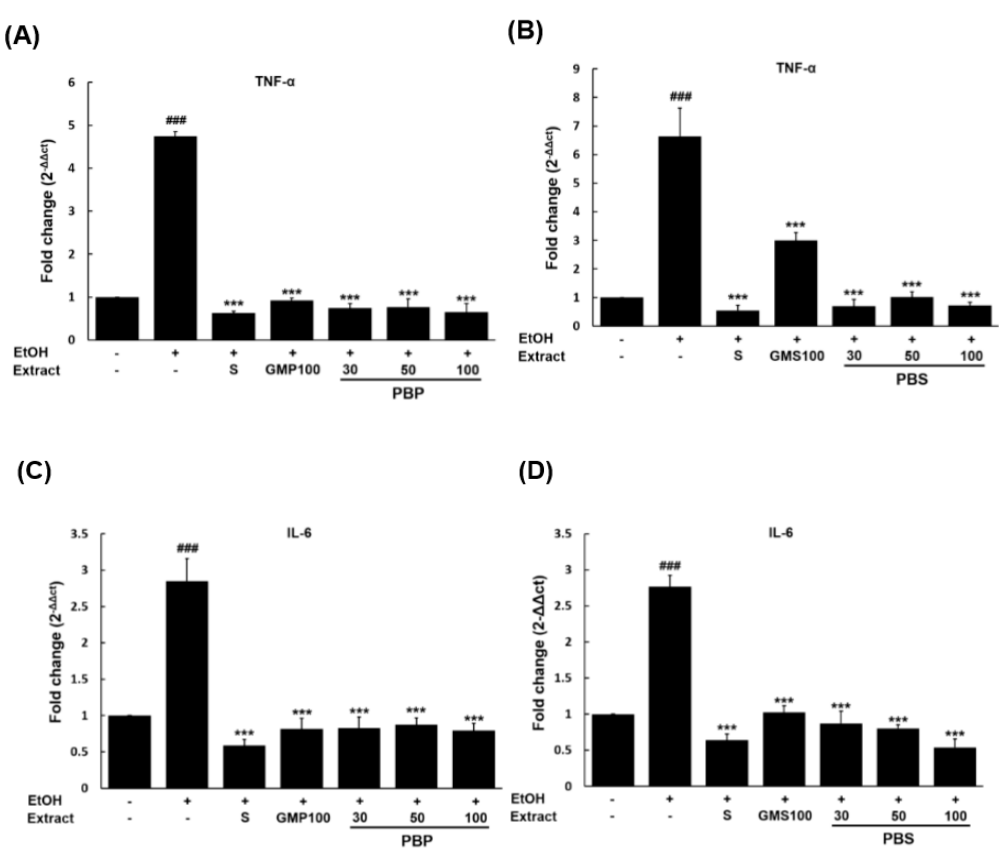
Figure 3. Anti-inflammatory potential of the paste and sauce made from PBL koji. TNF- α levels were analyzed after 300 mM EtOH treatment on HepG2 cells pretreated with 95% EtOH extract of each paste ( A ) and sauce ( B ). IL-6 levels were measured after 300 mM EtOH treatment on HepG2 cells pretreated with 95% EtOH extract of each paste ( C ) and sauce ( D ). S, silymarin (100 µ g / mL); GMP100, paste made from 100% GM; PBP30, paste made from 30% PBL / 70% GM; PBP50, paste made from 50% PBL / 50% GM; PBP100, paste made from 100% PBL; GMS100, sauce made from 100% GM; PBS30, sauce made from 30% PBL / 70% GM; PBS50, sauce made from 50% PBL / 50% GM; PBS100, sauce made from 100% PBL. The concentrations of the paste and sauce were 400 µ g / mL and 40 µ l / mL, respectively. Values are the means ± standard deviations of triplicate experiments. ### p < 0.001 indicates a significant di ff erence between the EtOH ( − ) / treatment ( − ) and the EtOH ( + ) / treatment ( − ). *** p < 0.001 indicates a significant di ff erence between the EtOH ( + ) / treatment ( − ) and the EtOH ( + ) / treatment ( + ).